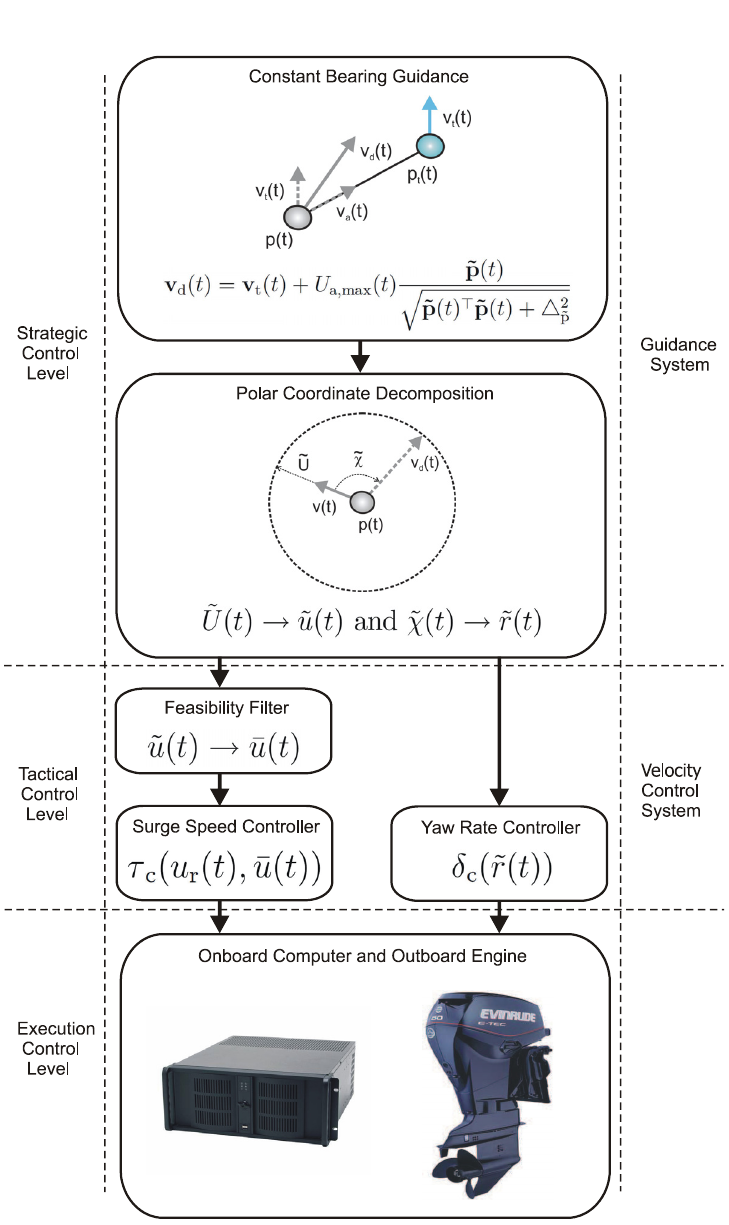
Figure 12: An illustration of the proposed motion control system capable of achieving high-speed target track- ing for underactuated USVs. By replacing the guidance system components, other motion control scenarios can also be